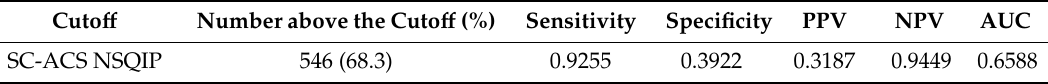
Table 5. Diagnostic characteristics of malignancy prediction according to the risk–benefit analysis using the predicted risk in the study cohort ( n =